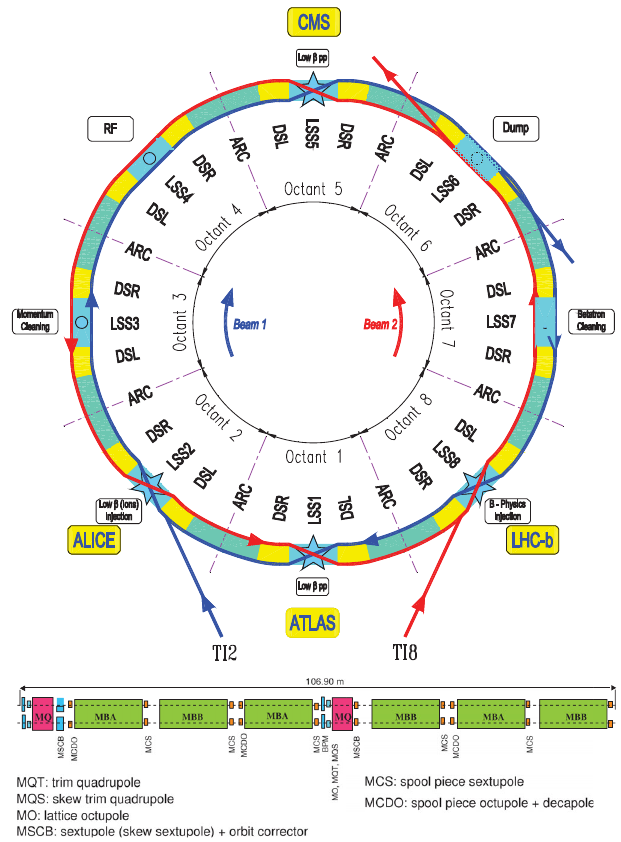
FIG. 3. Upper: Layout of the LHC (from Ref. [11]). The ring eight-fold symmetry is visible, together with the arcs and the long straight sections. Bottom: Layout of the LHC regular cell (from Ref. [11]). Six dipoles and two quadrupoles with the dipole, quadrupole, sextupole, and octupole magnets (for closed orbit, tune, chromaticity correction and beam stabilization, respec- tively) are shown. The spool pieces used to compensate the systematic b 3 component (MCS), b 4 and b 5 components (MCDO nested magnets) are also shown. The field imperfections of LHC P M ð b þ ia Þð x þ iy Þ n − 1 magnets are given as B y þ iB x ¼ B n n n ¼ 1 R ref r ¼ 17 where R r